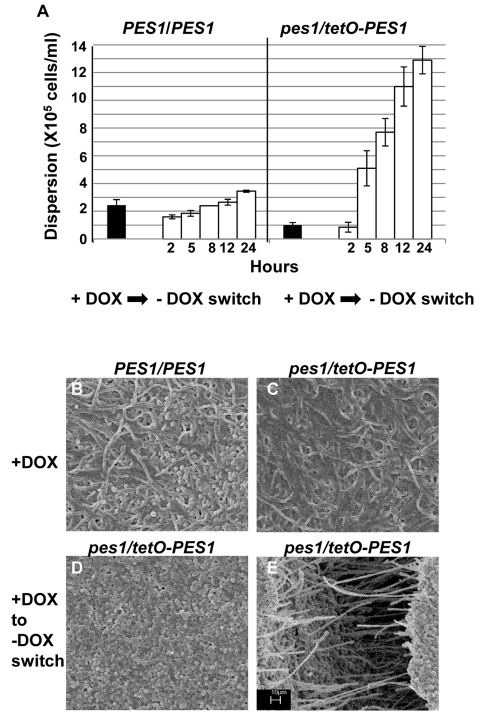
Regulation of C. albicans biofilm dispersion by PES1.Biofilms (formed by the C. albicans PES1/PES1 and tetO-PES1 strains) were developed for 17 hours in YNB with DOX, and the number of dispersed cells counted. DOX was withdrawn from the media and number of dispersed cells counted at various time points after antibiotic removal (A). Biofilms formed by the C. albicans PES1/PES1 and tetO-PES1 strains were developed in the presence of DOX (B and C respectively). Impact of change DOX withdrawal on the tetO-PES1 biofilm is shown in panel D. Panel E shows the morphology of the cells in a crack in the tetO-PES1 biofilm developed after removal of the antibiotic from the medium. Since PES1/PES1 showed similar biofilm phenotype before and after media change, only one representative image for both conditions is shown. Scale bar for SEM corresponds to 10 µm for all four images.